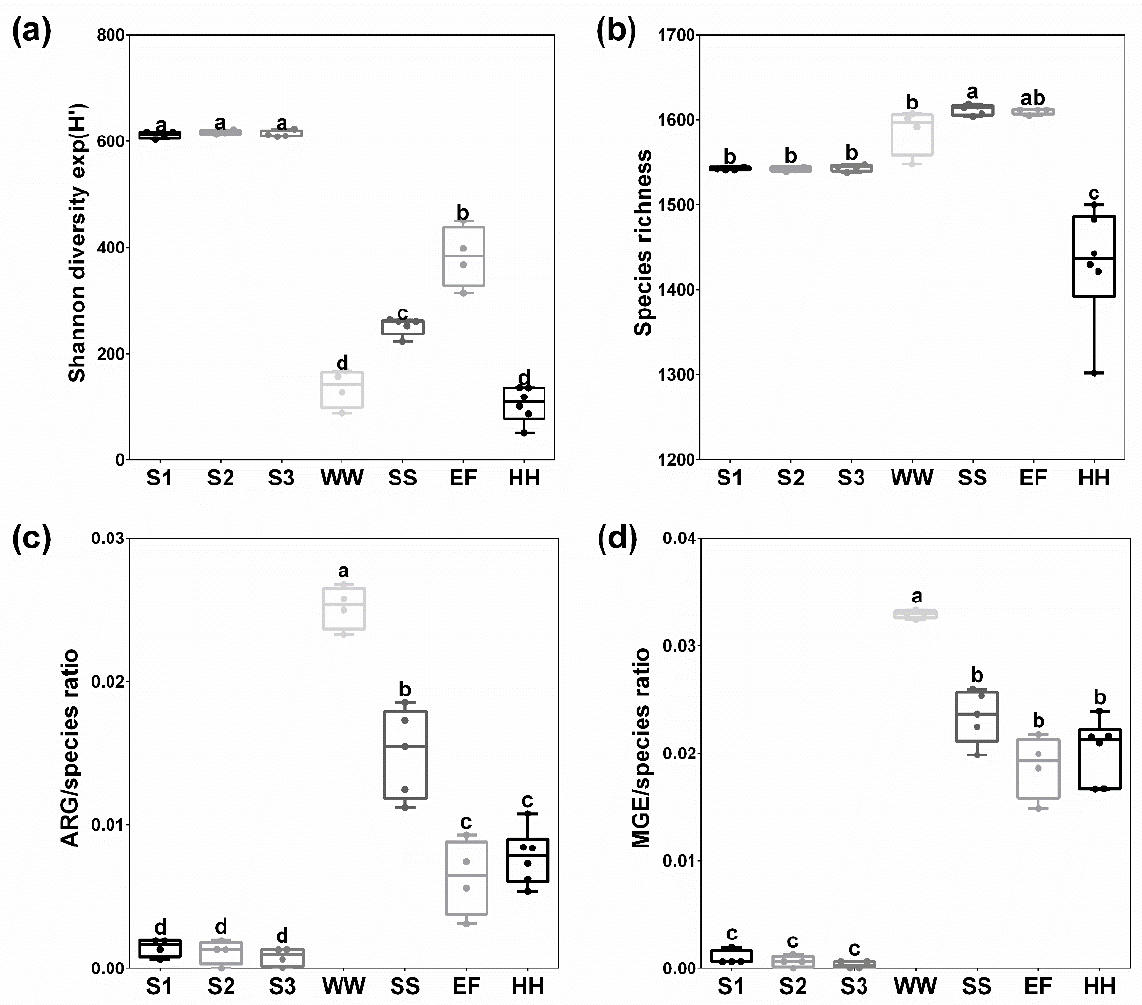
Figure 1. Exponential Shannon index ( a ), species richness ( b ), ARG/species ( c ) and MGE/species ratio ( d ) (count of ARG/MGE per species) of different soils (S1, S2 S3, each n = 4), wastewater (WW, n = 4), sewage sludge (SS, n = 5), WWTP effluent (EF, n = 4) and household samples (HH, n = 6). Different letters (a–d) indicate significant differences calculated using non-parametric Mann–Whitney test while the same letter above a bar indicates no significant differences. The letters themselves do not have a specific meaning and are only used to ameliorate presentation of significant differences.